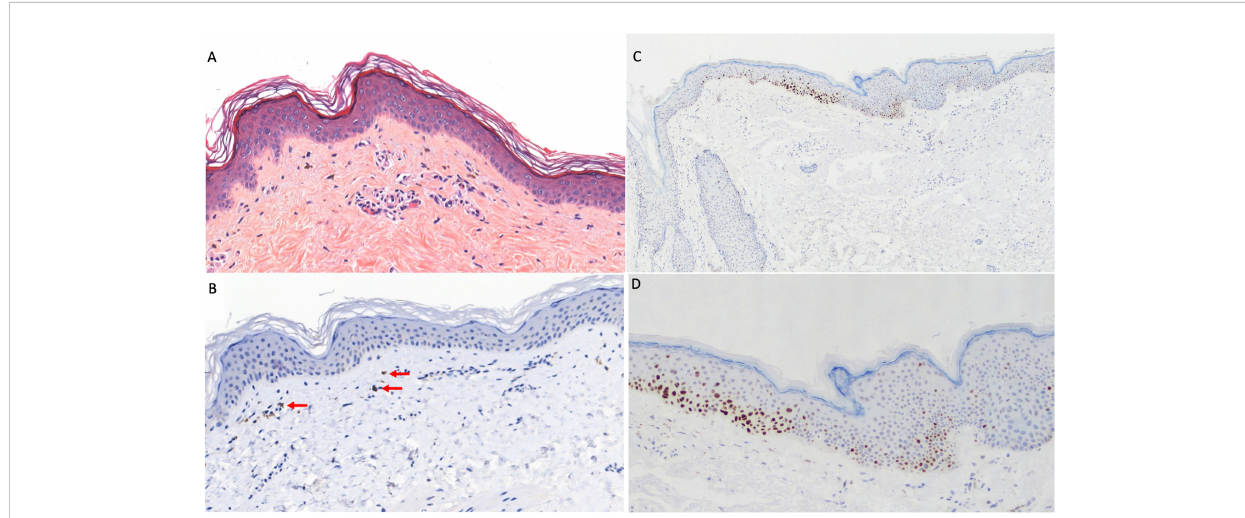
FIGURE 2 Skin histopathologic and immunohistochemical examination. (A) Mild perivascular lymphocytic in fi ltrate in the super fi cial dermis extended along the basal layer (hematoxylin – eosin, original magni fi cation ×100). (B) Focally detected melanin (red arrows) in few dermal melanophages (melan-A monoclonal antibody, A103, Invitrogen; original magni fi cation ×100). (C, D) Strong P53 expression (mouse monoclonal anti-P53 antibody MS – 738- R7-LabVision/Neomarkers, USA) in basal and supra-basal layers in depigmented skin at original magni fi cation ×50 (C) and ×100 (D) .